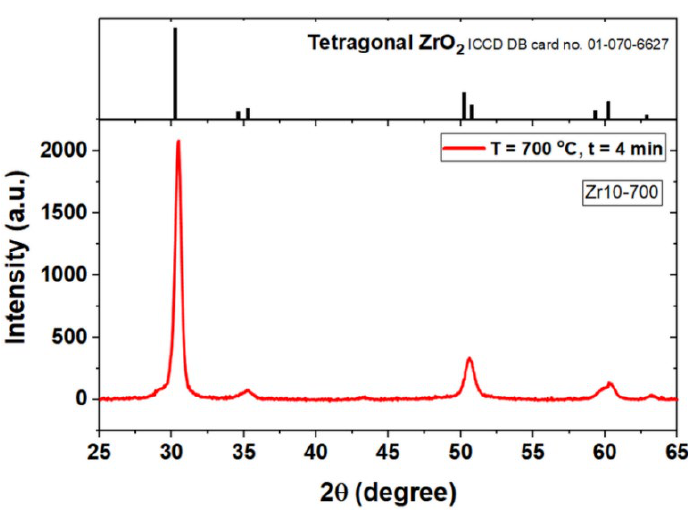
Figure 3. XRD spectra of the sample obtained after 4 minutes at 700 °C RTA (Zr10-700). The XRD diffractogram presents high intensity peaks positioned at 2θ = 30.48 deg, 2θ = 35.2 deg, 2θ = 50.6 deg , and 2θ = 60.32 deg. These peaks correspond to a high -pressure tetragonal phase of the ZrO 2 , indexed in the ICCD DB card no. 01-070-6627, for the crys- tallographic planes of (111), (002), (200), and (211), respectively. The 30.48 deg peak corre- sponds to the (111) plane with a lattice spacing of 0.293 nm, which is smaller than the 0.295 nm (for 30.28 deg) of the tetragonal lattice phase. However, the experimental (111) peak has a very large base (from 28.4 to 31.5 deg) covering the positions of the (-111) and (111) peaks of the monoclinic phase of the ZrO 2 . This monoclinic phase is present in several percentages in the structure and explains the small coherence size of the ZrO 2 crystallites. At room temperature and atmospheric pressure, the most stable phase of ZrO 2 is the monoclinic phase, which is characterized by a lower value of the dielectric constant com- pared with the tetragonal phase. In our case, by co-depositing between 10% Zr–90% ZrO 2 for the floating gate layer, some amorphous zones of the ZrO 2 at the nanometric scale will probably appear. A possible explanation for the tetragonal phase being the majority phase in the tri- layer structure is that during the RTA at 700 °C, the crystallization starts in both the tun- neling ZrO 2 and the gate ZrO 2 and continues in the floating gate layer, similarly to the case of HfO 2 -based trilayers. [26]. In the present case, the internal strain appears by oxygen vacancy formation and is also due to the 10% Zr excess in the floating gate. We also performed X-ray photoelectron spectroscopy (XPS) measurements at the sur- face of the trilayer structure (Figure 4). As it can be seen, the Zr 3d doublets Zr 3d 5/2 and Zr 3d 3/2 have a splitting energy of 2.4 eV and an area ratio of 3/2. The binding energy clearly indicates that Zr is in an oxida- tion state; therefore, there is no metallic Zr in the ZrO 2 gate oxide layer contributing to the formation of the tetragonal phase of ZrO 2 .